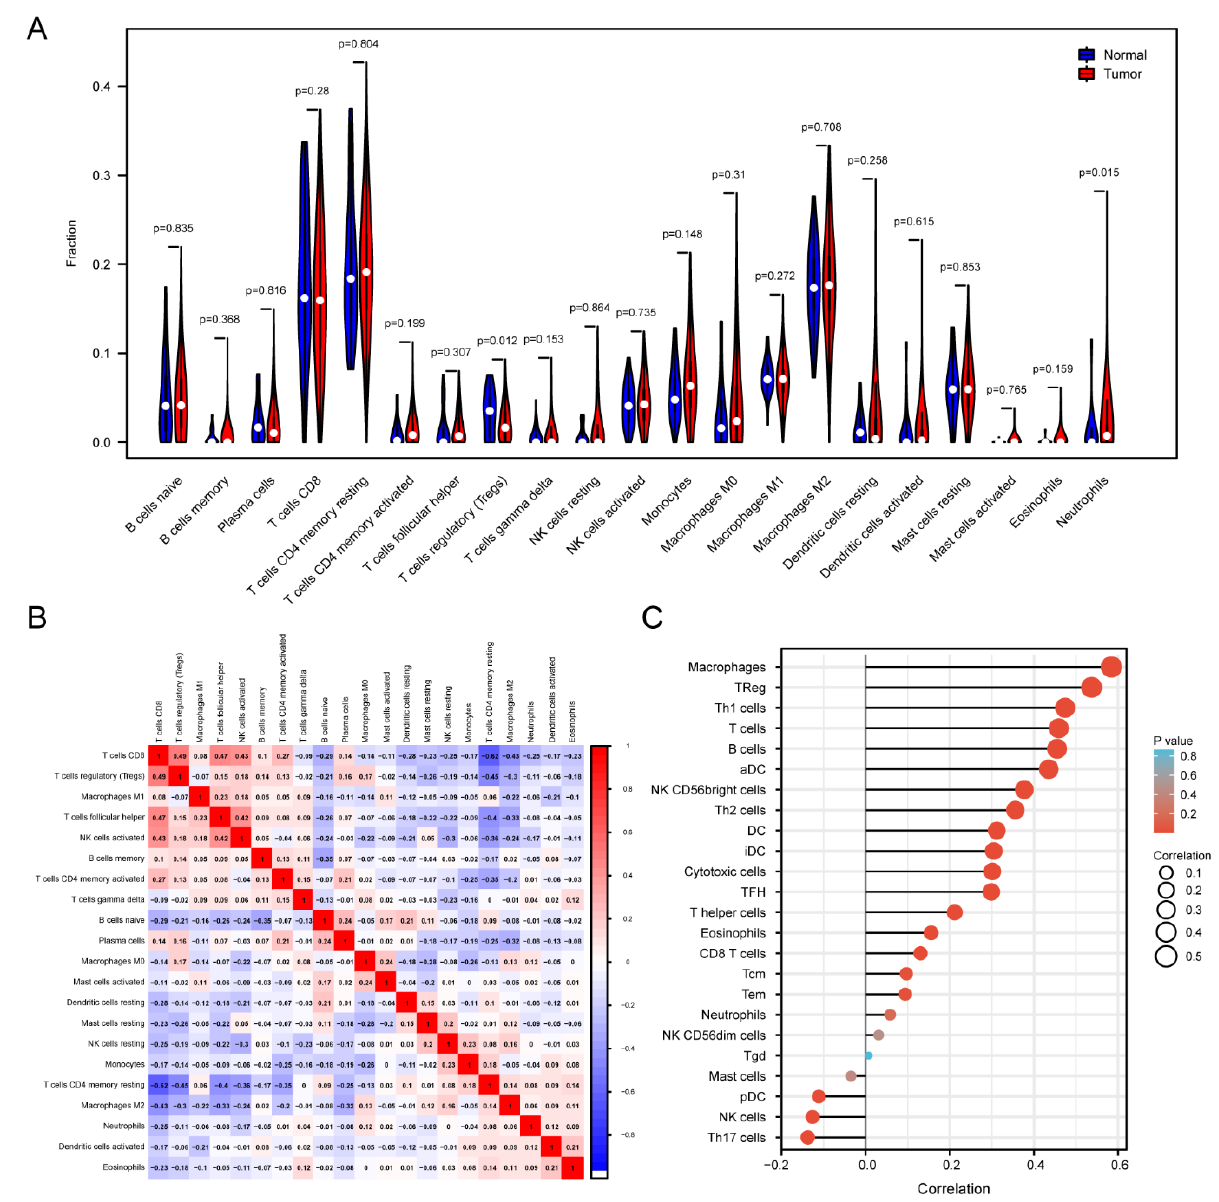
Figure 3. Infiltration of immune cells in KIRC patients. ( A ) The differences in 22 subtypes of immune cells between high and low expression levels of HAMP in kidney cancer. The group with a high expression level of HAMP is shown in red and the low − HAMP group is shown in blue. ( B ) Heatmap of the immune infiltration cells in tumor samples. ( C ) Lollipop chart comparing the degree of infiltration of the 24 immune cells in